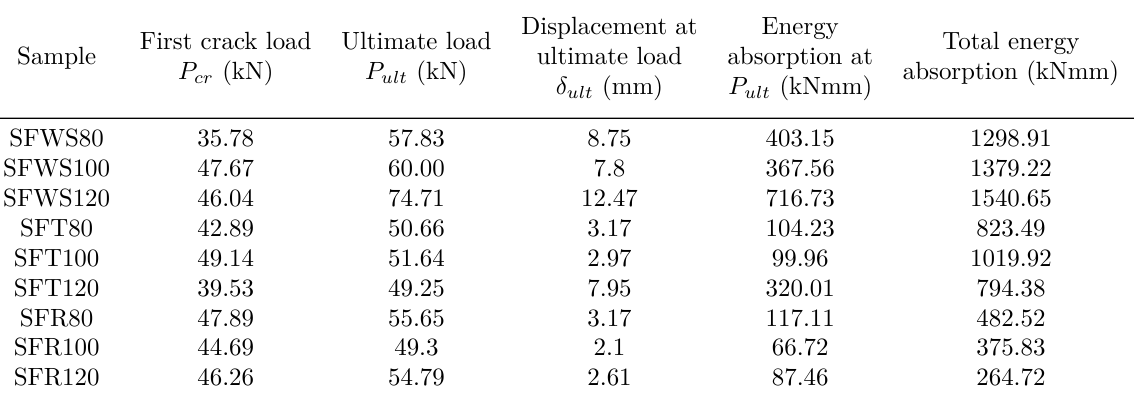
Table 4. Flexural test